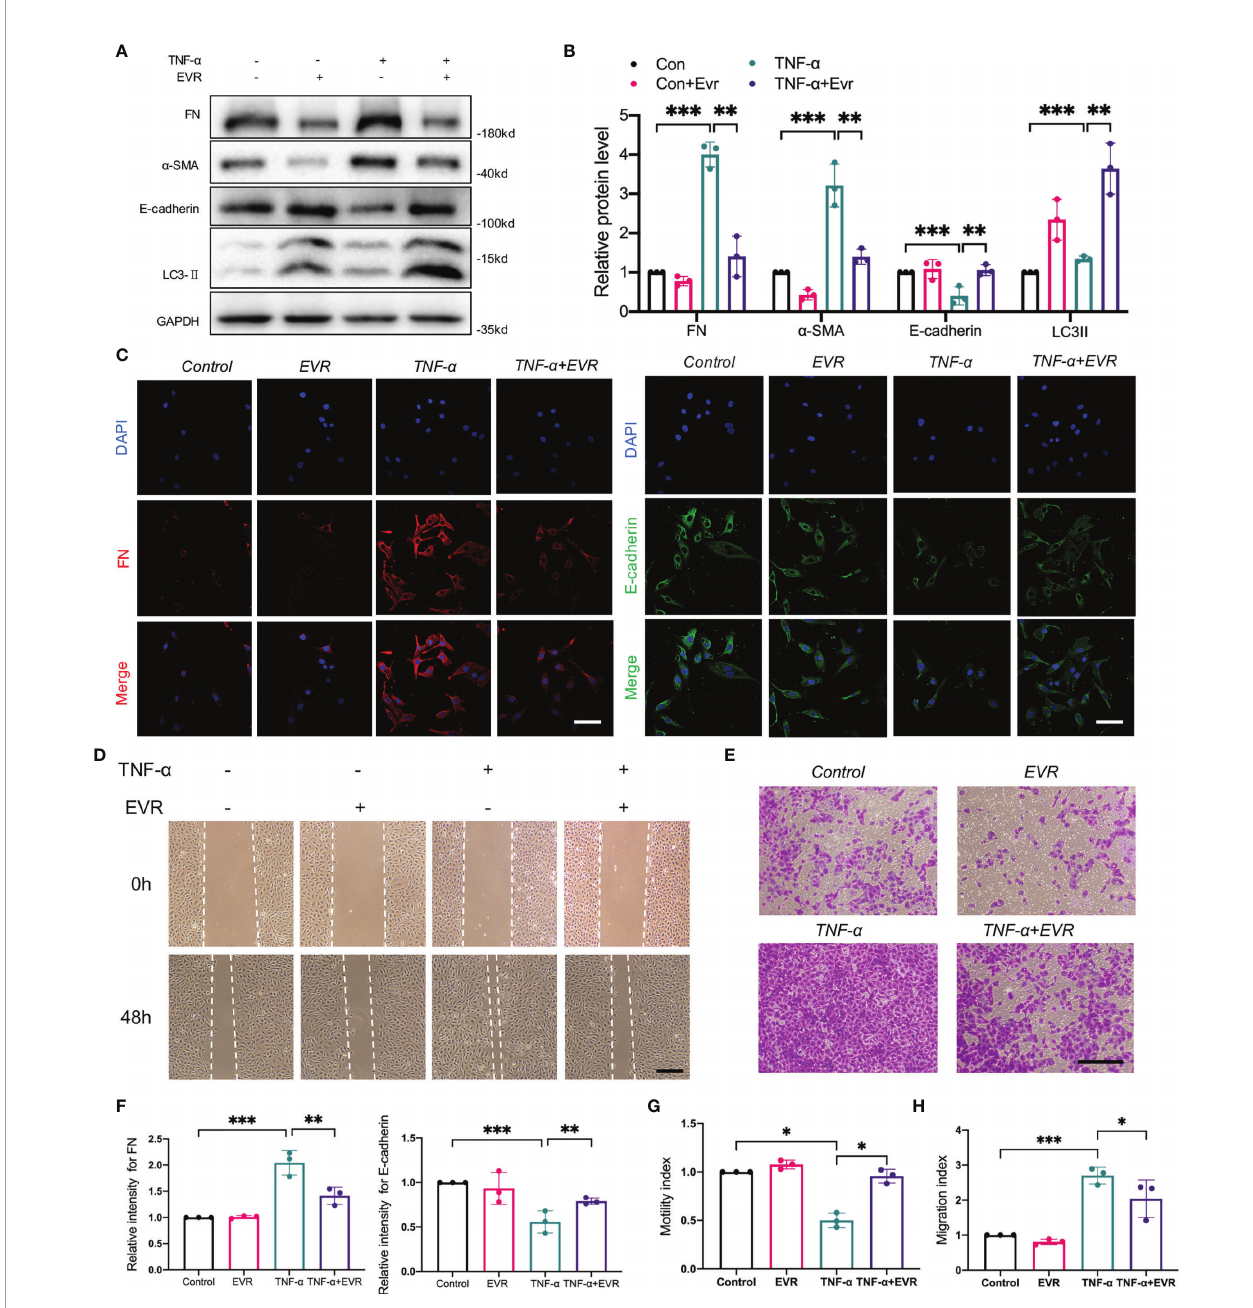
FIGURE 5 | EVR alleviated the TNF- a ‐ mediated EMT, cell migration, and invasion in HK2 cells. (A) Representative Western blotting results of EMT markers (E- cadherin, a -SMA, and FN) and LC3-II in HK-2 cells treated with TNF- a (50 ng/ml) and/or EVR (10 nM) for 48 h. (B) Semi-quantitative analyses results of relative protein abundances of E-cadherin, a -SMA, FN, and LC3-II in HK-2 cells treated with TNF- a and/or EVR for 48 h. Values represented the mean ± SD ( n = 6, ** p < 0.01, *** p < 0.001). (C) Representative IF staining images of E-cadherin and FN in HK-2 cells treated with TNF- a (50 ng/ml) and/or EVR (10 nM) for 24 h (scale bar: 20 m m). (D) Representative wound healing test images on HK-2 cells treated with TNF- a (50 ng/ml) and/or EVR (10 nM) for 48 h (scale bar: 20 m m). (E) Representative transwell assay images on HK-2 cells treated with TNF- a (50 ng/ml) and/or EVR (10 nM) for 48 h (scale bar: 20 m m). (F) Semi-quantitative analyses results of relative IF staining intensity of E-cadherin and FN in HK-2 cells treated with TNF- a (50 ng/ml) and/or EVR (10 nM) for 24 h. Values represented the mean ± SD ( n = 3, ** p < 0.01, *** p < 0.001). (G) Quantitative analyses results of the motility index of HK-2 cells treated with TNF- a and/or EVR for 48 h; the motility index has determined by the formula “ migration cell number of control group/migration cell number of the other treatment group ” . Values represented the mean ± SD ( n = 3, * p < 0.05). (H) Quantitative analyses results of the migration index of HK-2 cells treated with TNF- a and/or EVR for 48 h; the migration index as determined by the formula “ migration cell number of the other treatment group/migration cell number of control group ” . Values represented the mean ± SD ( n = 3, * p < 0.05, *** p < 0.001). a -SMA, a -smooth muscle actin; EVR, everolimus; EMT, epithelial – mesenchymal transition; FN, fi bronectin; TNF- a , tumor necrosis factor- a